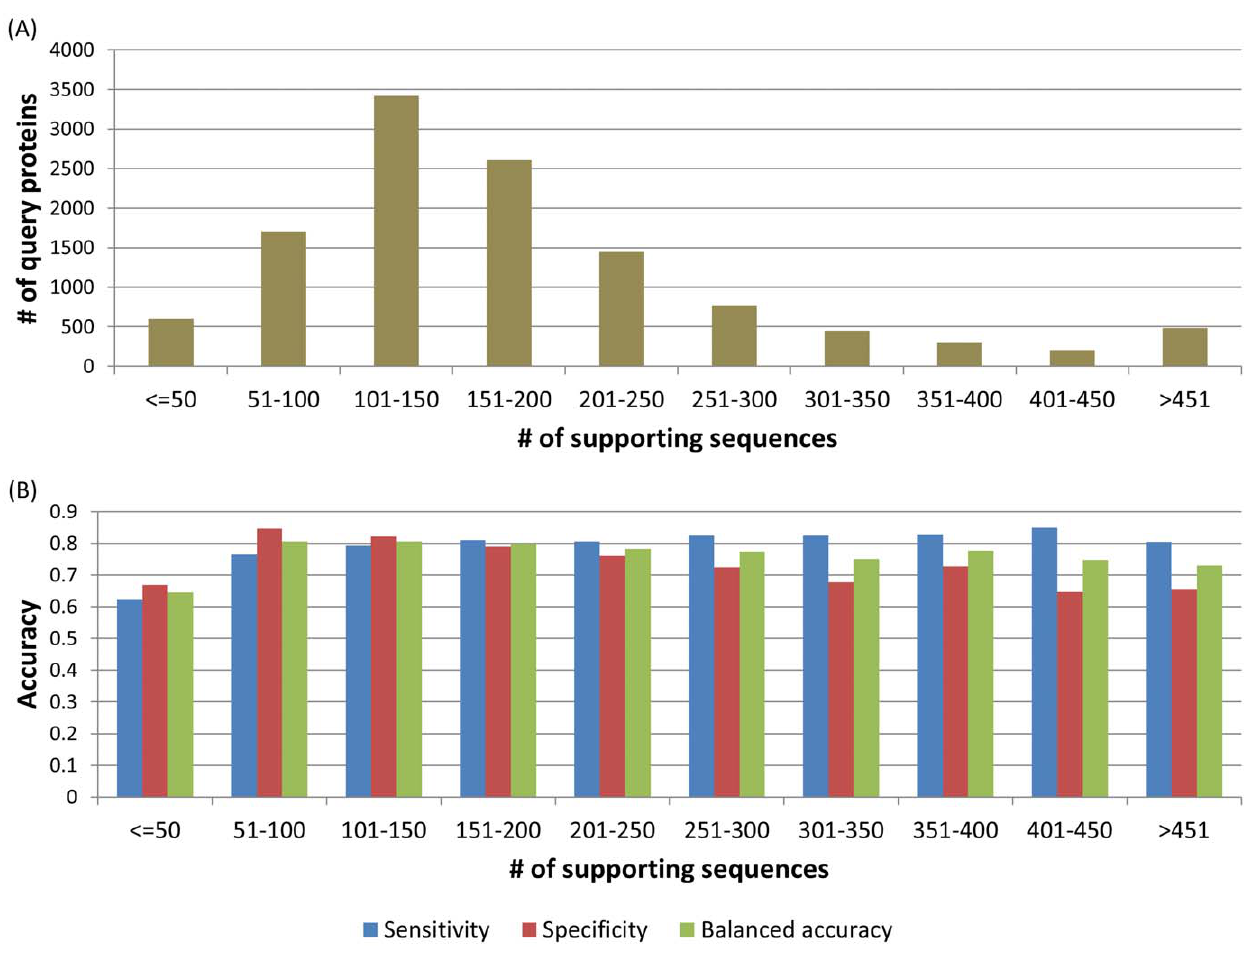
Figure 9. Number of supporting sequences used for the Uniprot human proteins carrying neutral or deleterious variants. (A) Distribution of the 11,990 human proteins based on the number of supporting sequences used for PROVEAN prediction. (B) Prediction accuracy achieved with respect to the number of supporting sequences. The observed accuracy is consistently above 73%, except in cases when the number of supporting sequences drops below